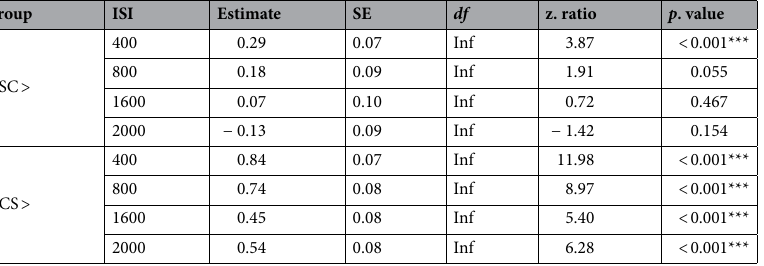
Table 3. Pairwise comparisons of estimated marginal means (EMMs) for each ISI level. Post-hoc comparisons on the Ordinal position of the longer stimulus, within each Group and each level of ISI, revealed that for the <SC> group the only statistically significant comparison was at the ISI 400 , whereas for the <CS> group all pairwise comparisons were statistically significant. (*** p -value < 0.001).